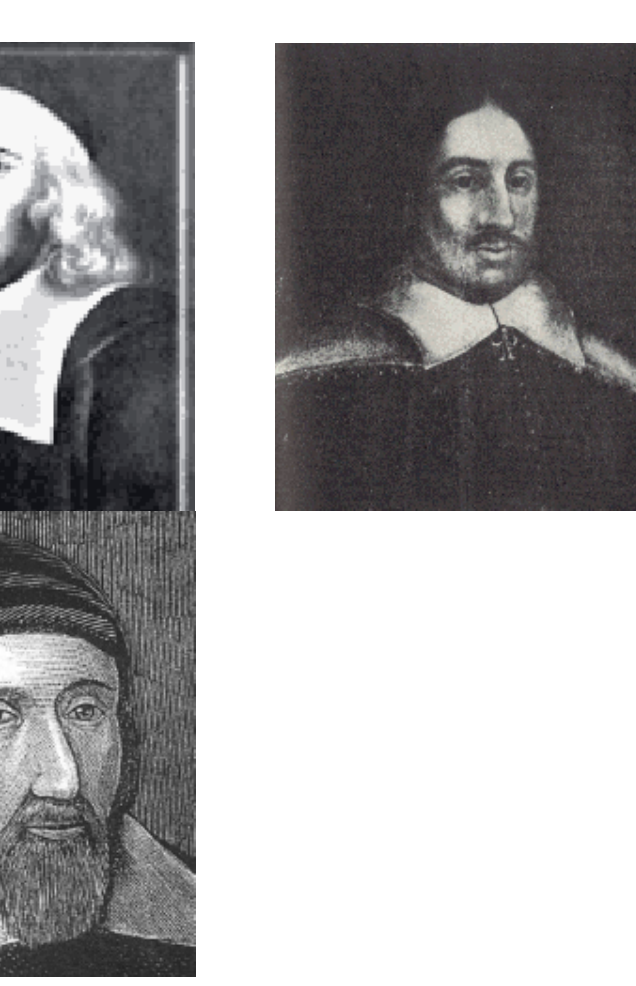
Figure A1. Puritan Settlers (Taken from the Winthrop Society website).